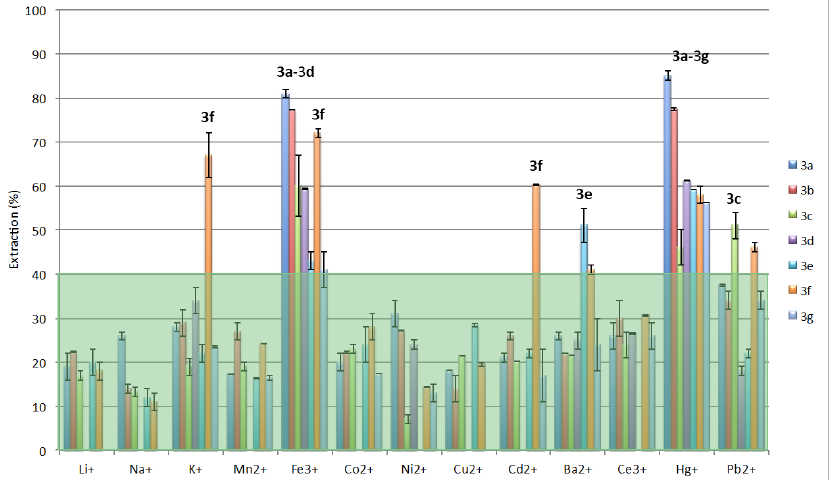
Figure 4. Extraction efficiencies of metal cations by the triazolic piperazine polymers 3a – 3g (polymers extracting at levels ≥50% are